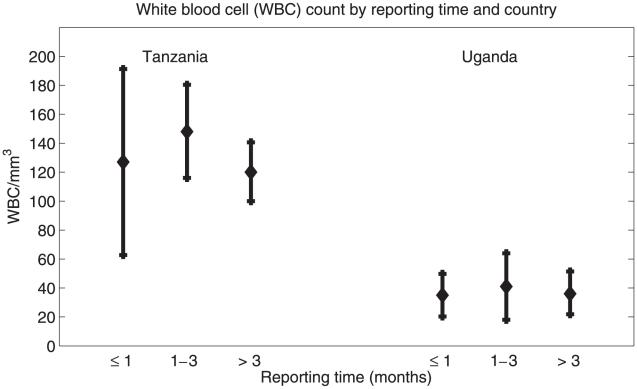
Mean and 95% confidence interval for white blood cell (WBC) count in the central nervous system (CNS) by country and reporting time.